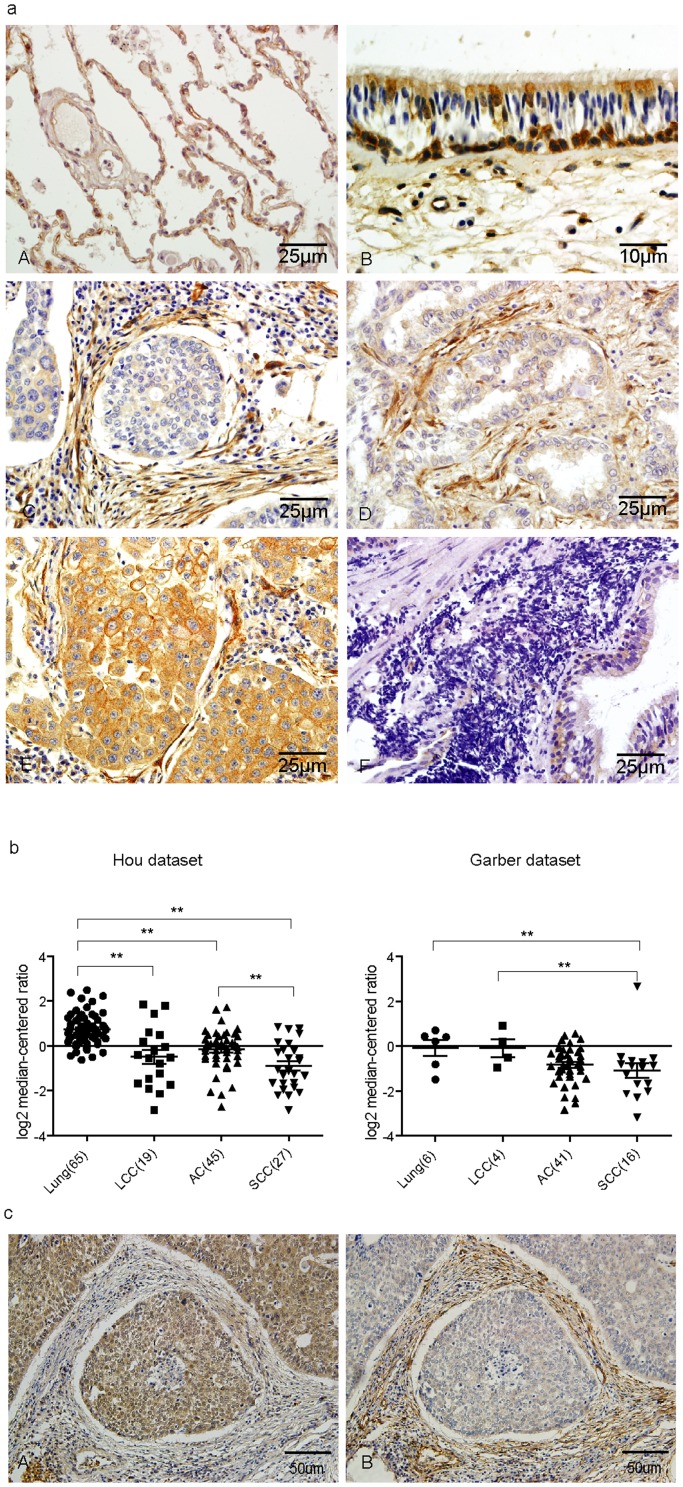
The expression pattern of Kindlin-2 in different subtypes of lung cancer.a. Kindlin-2 expression in tissues from normal and lung cancer tissues examined by IHC. Photos displayed are normal lung (A), Pseudo-stratified ciliated columnar epithelium (B), SCC (C), AC (D), LCC (E), and SCLC (F). b. Re-analyses of Kindlin-2 expression in Oncomine database. Left: Kindlin-2 expression extracted from Hou lung dataset; Right: Kindlin-2 expression extracted from Garber lung dataset. Statistical analyses between different patient groups were examined by Student's t test. ** represents for p<0.01. c. Comparison of the expressions of Kindlin-1 and Kindlin-2 in SCC from the same patient. As displayed Kindlin-2 is highly expressed in tumor stroma, but not in lung cancer cells.